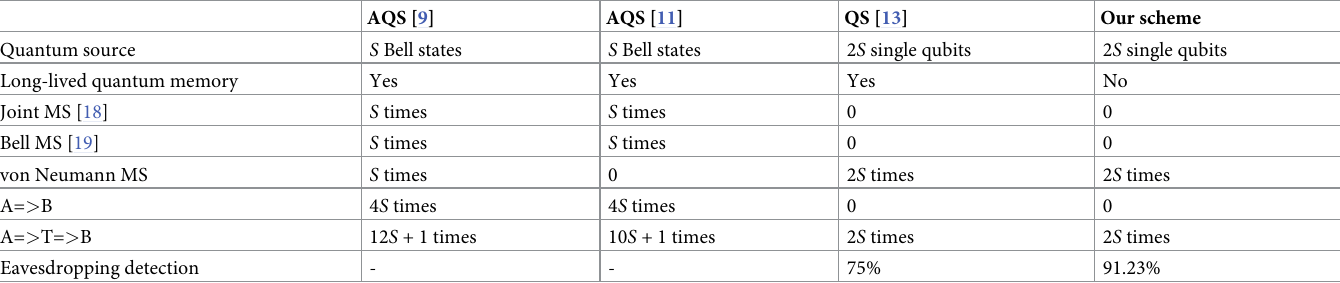
Table 2. Comparison of the main operations in the quantum signature